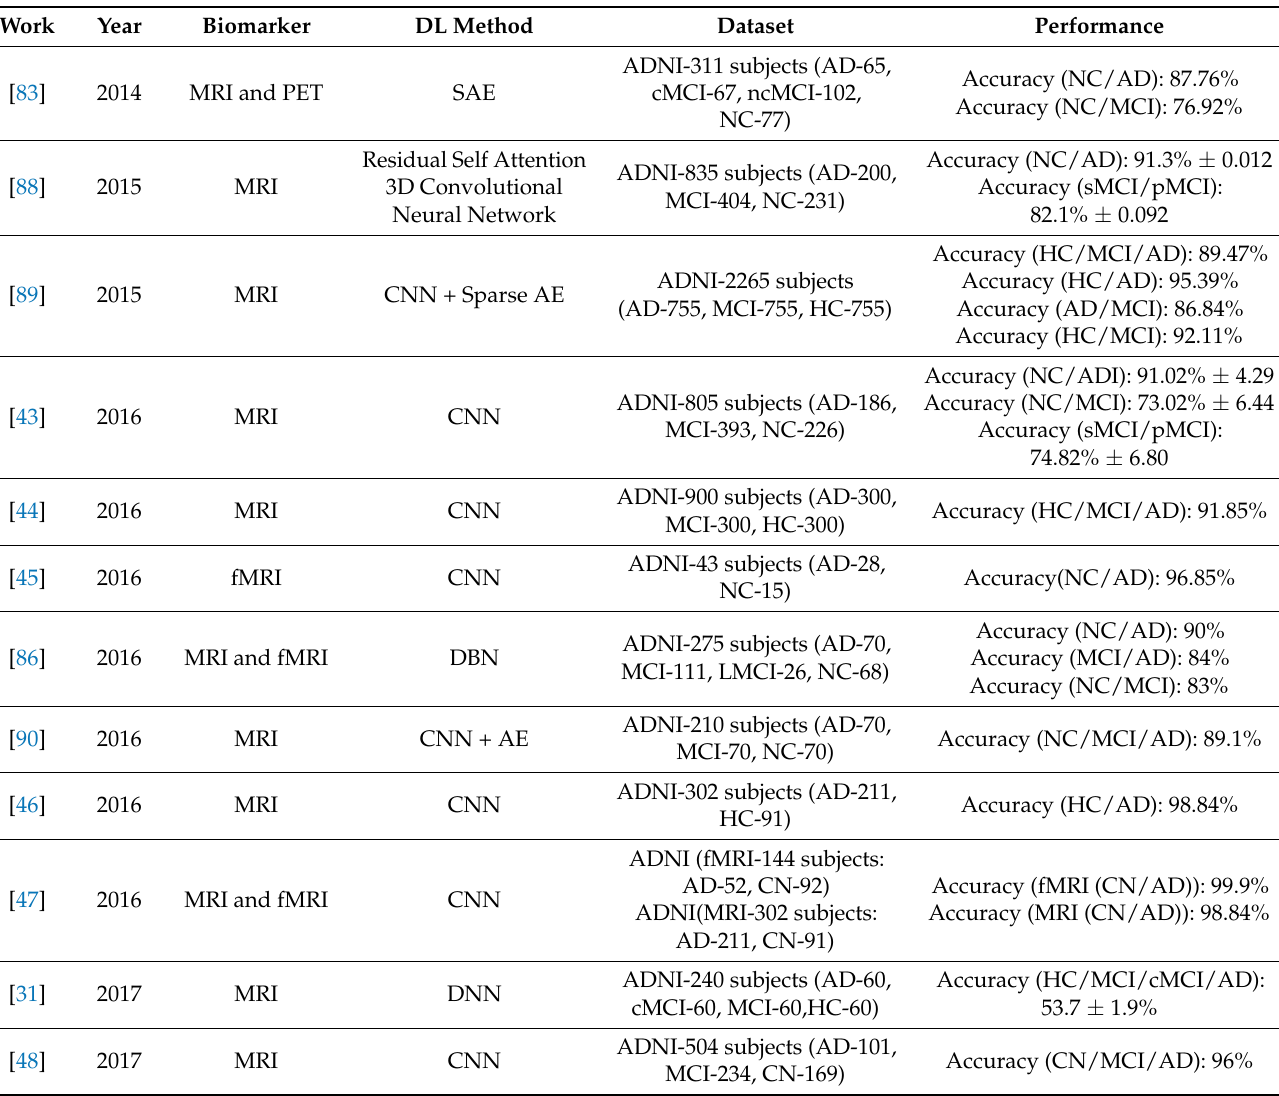
Table 1. Summary of research